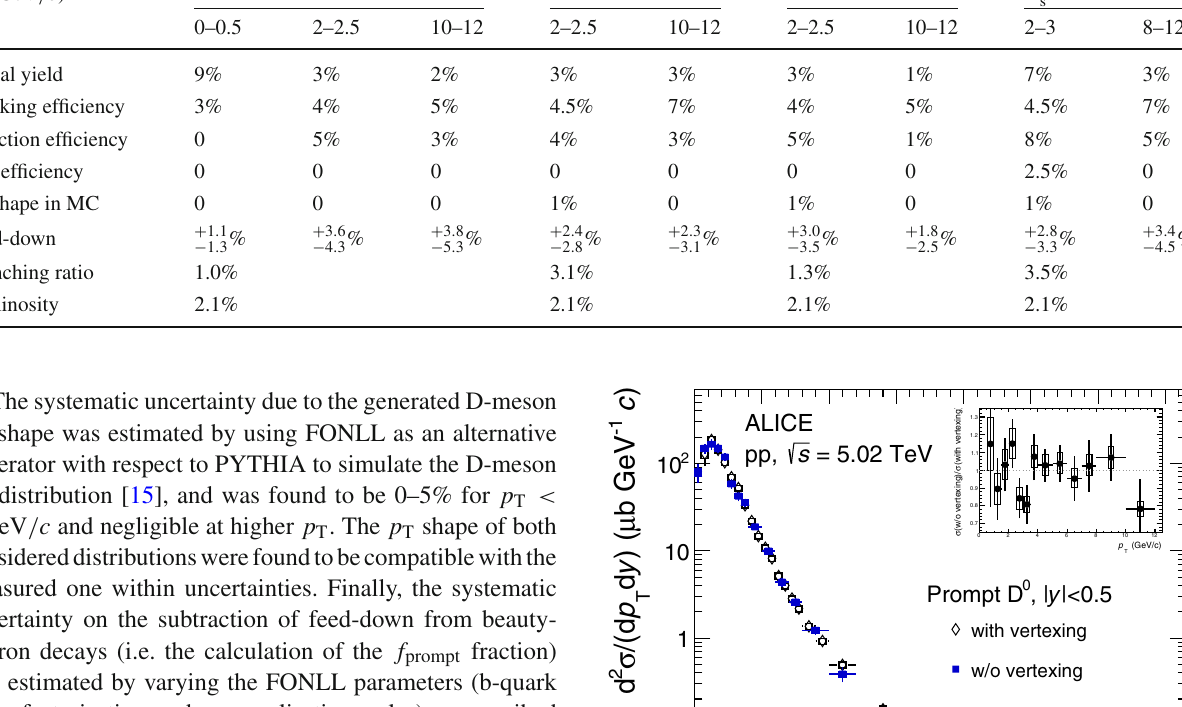
Table 1 Summary of relative systematic uncertainties on D 0 , D + , D ∗+ , and D + s measurements in different p T intervals p T (GeV / c )